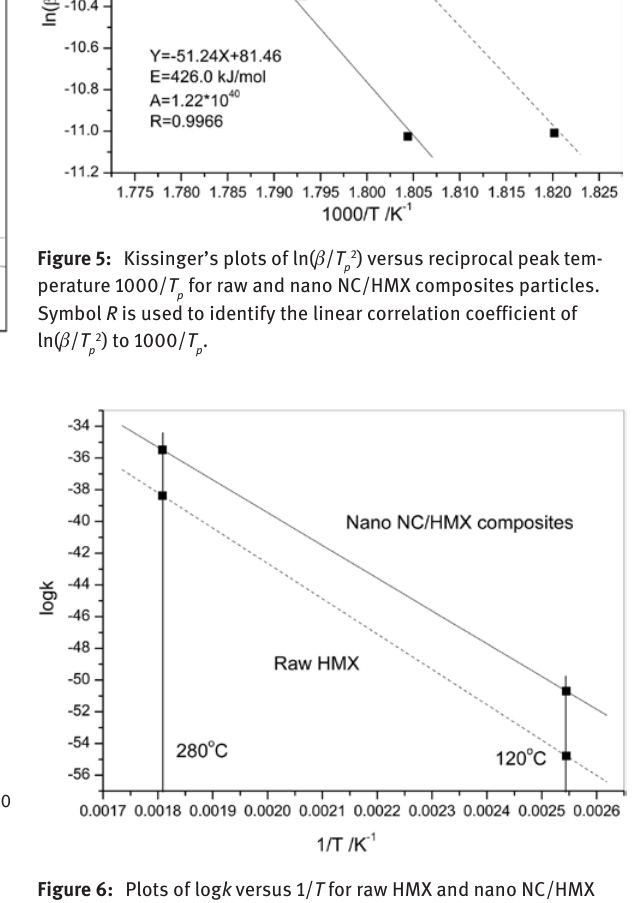
Figure 6: Plots of log k versus 1/ T for raw HMX and nano NC/HMX